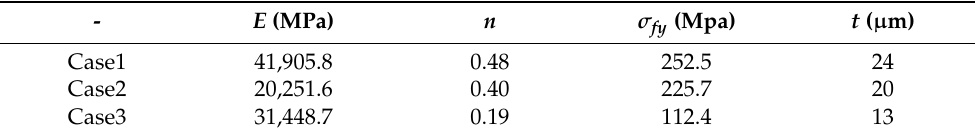
Table 2. Three new randomly determined working